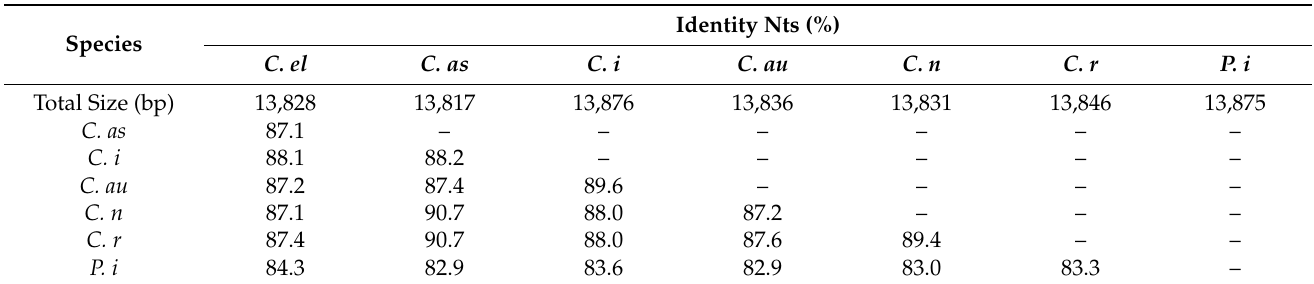
Table 2. The identities of nucleotides sequences of complete mt genomes among 6 Cylicocyclus species and P. imparidentatum